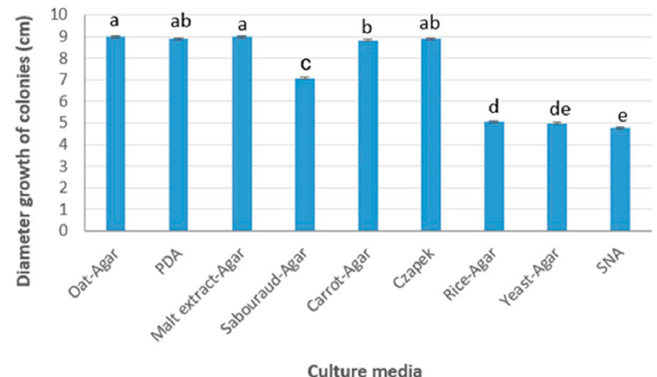
Figure 1. Diameter growth of colonies (cm) on nine different culture media after 10 days. Mean and standard deviation is expressed in the error bar ( n = 3). Different letters indicate a significant difference (Tukey test, p ≤ 0.05). Table 2. Conidia production of C. virescens INIFAT C10/110 on different culture media after 10 days.